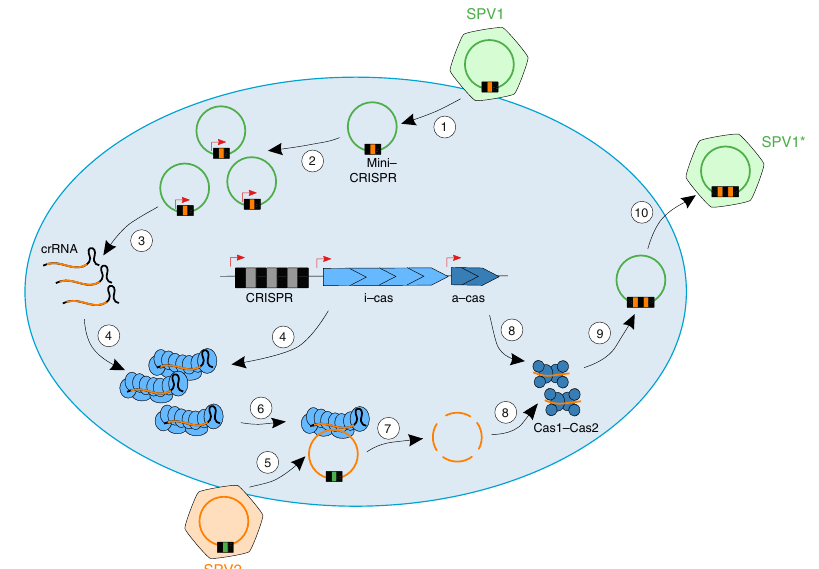
Fig. 6 Proposed mechanism of CRISPR-mediated interviral con fl ict. 1: SPV1 carrying mini-CRISPR array with a spacer against SPV2 infects a susceptible host; 2: SPV1 genome replication results in increased copy number of the mini-CRISPR arrays compared to the chromosomal CRISPR arrays; 3: transcription of the mini-CRISPR arrays; 4: viral crRNAs are complexed with the cellular interference module (i-cas); 5: secondary coinfection of the same cell with SPV2; 6 and 7: SPV2 genome is recognized and degraded by the effector module; 8: fragments of the SPV2 genome are loaded on the cellular Cas1-Cas2 adaptation complex (a-cas); 9: mini-CRISPR array of SPV1 is upgraded with new spacers against SPV2; 10: New variant of SPV1 (SPV1*) is released and spreads the immunity in the